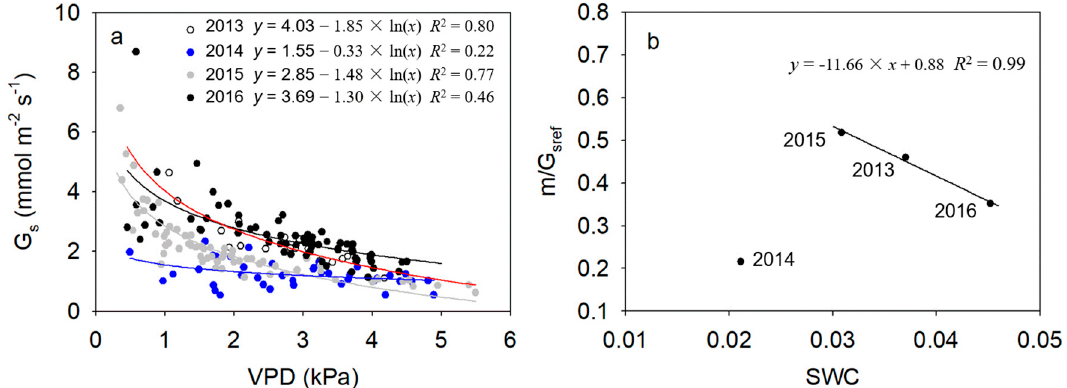
Figure 5. Relationships between mean daily canopy stomatal conductance (G s ) and daily average vapor pressure deficit (VPD) under conditions of high radiation (daily average PPFD > 200 µ mol m − 2 s − 1 ) during the second half of the growing season (1 August to early October) from 2013 to 2016 ( a ) and inter-annual relationship between the ratio of stomatal sensitivity to reference stomatal conductance (m/G sref ) and annual average volumetric soil water content (SWC) ( b ).